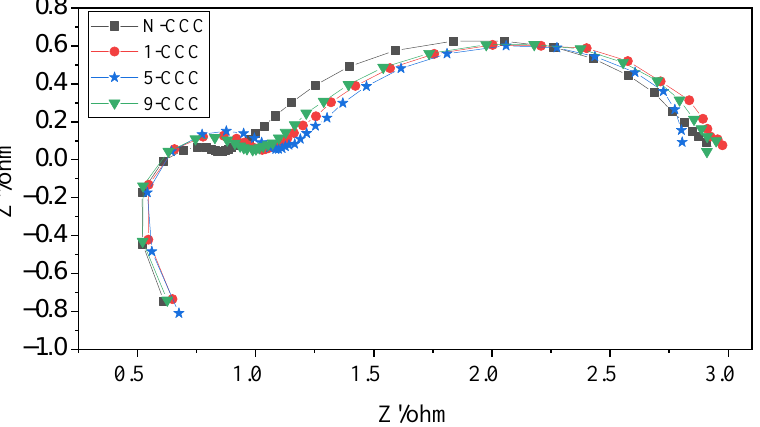
Figure 12. EIS of µ DMFC with different gradient wettability CCC before discharge.